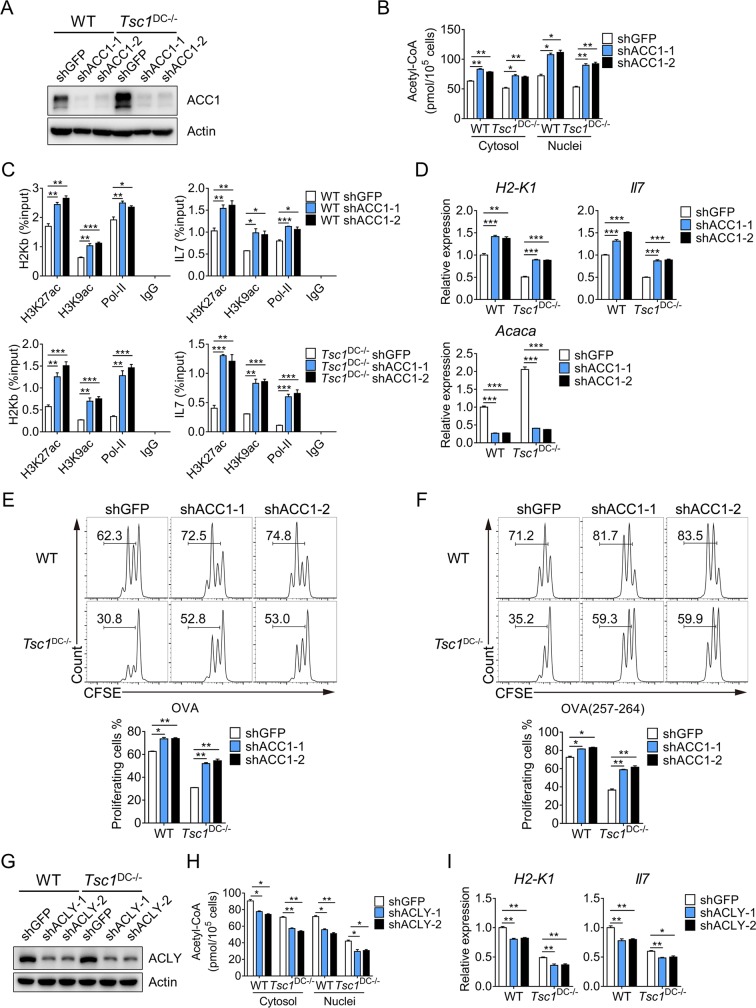
ACC1 controls acetyl-CoA production and MHC-I/IL-7 expression in DC.(A) Whole-cell lysates prepared from control (shGFP) and ACC1-knockdown BMDCs were immunoblotted with indicated antibodies. (B) The acetyl-CoA levels in the cytosol and nucleus of control (shGFP) and ACC1-knockdown BMDCs were measured. This experiment was repeated once with similar results. The data are presented as means ± SEM (*p < 0.05, **p < 0.01, analyzed by Student’s t test). (C) Control and ACC1-knockdown BMDCs were cross-linked, and the cell lysates were immunoprecipitated with indicated antibodies. Immunoprecipitated H2k1 and Il7 promoter DNA fragments were measured by real-time PCR and quantified over respective inputs. This experiment was conducted twice with similar results. The data are presented as means ± SEM (*p < 0.05, **p < 0.01, ***p < 0.001; analyzed by Student’s t test). (D) The expression of H2k1, Il7, and Acaca were measured by real-time PCR. This experiment was performed twice with similar results, and the data are presented as means ± SEM (**p < 0.01, ***p < 0.001, analyzed by Student’s t test). (E and F) Control and ACC1-knockdown BMDCs were pulsed with 0.25 mg/ml OVA (E) or 0.1 ng/ml OVA257-264 (F) for 6 hours and 1 hour, respectively. The treated BMDCs were cocultured with CFSE-labeled OT-I CD8+ T cells for 2 days, and the proliferation of OT-I CD8+ T cells was analyzed by flow cytometry. This experiment was conducted twice with similar results. The data are presented as means ± SEM (*p < 0.05, **p < 0.01, analyzed by Student’s t test). (G) Whole-cell lysates prepared from control and Acly-knockdown BMDCs were probed with indicated antibodies. (H) The acetyl-CoA levels in the cytosol and nuclei of control and Acly-knockdown BMDCs were measured. This experiment was repeated once with similar results. The data are presented as means ± SEM (*p < 0.05, **p < 0.01, analyzed by Student’s t test). (I) Total mRNAs of control and Acly-knockdown BMDCs were extracted for real-time PCR analysis of H2k1 and Il7 expression levels. This experiment was performed twice with similar results. The data are presented as means ± SEM (*p < 0.05, **p < 0.01, analyzed by Student’s t test). Underlying data are available in S1 Data and S1 Raw Images. Acaca, acetyl-CoA carboxylase alpha; ACC1, acetyl-CoA carboxylase 1; acetyl-CoA, acetyl-coenzyme A; Acly, ATP-citrate lyase; BMDC, bone marrow–derived DC; CD, cluster of differentiation; CFSE, carboxyfluorescein diacetate succinimidyl ester; GFP, green fluorescent protein; H2-K1, histocompatibility 2, K1, K region; H2-Kb, histocompatibility 2, K1, K region; H3K27ac, acetyl-histone H3 (Lys27); H3K9ac, acetyl-histone H3 (Lys9); IgG, immunoglobulin G; IL, interleukin; MHC, major histocompatibility complex; OVA, ovalbumin; Pol-II, RNA polymerase II; sh, short hairpin; Tsc1, tuberous sclerosis complex subunit 1; WT, wild-type.